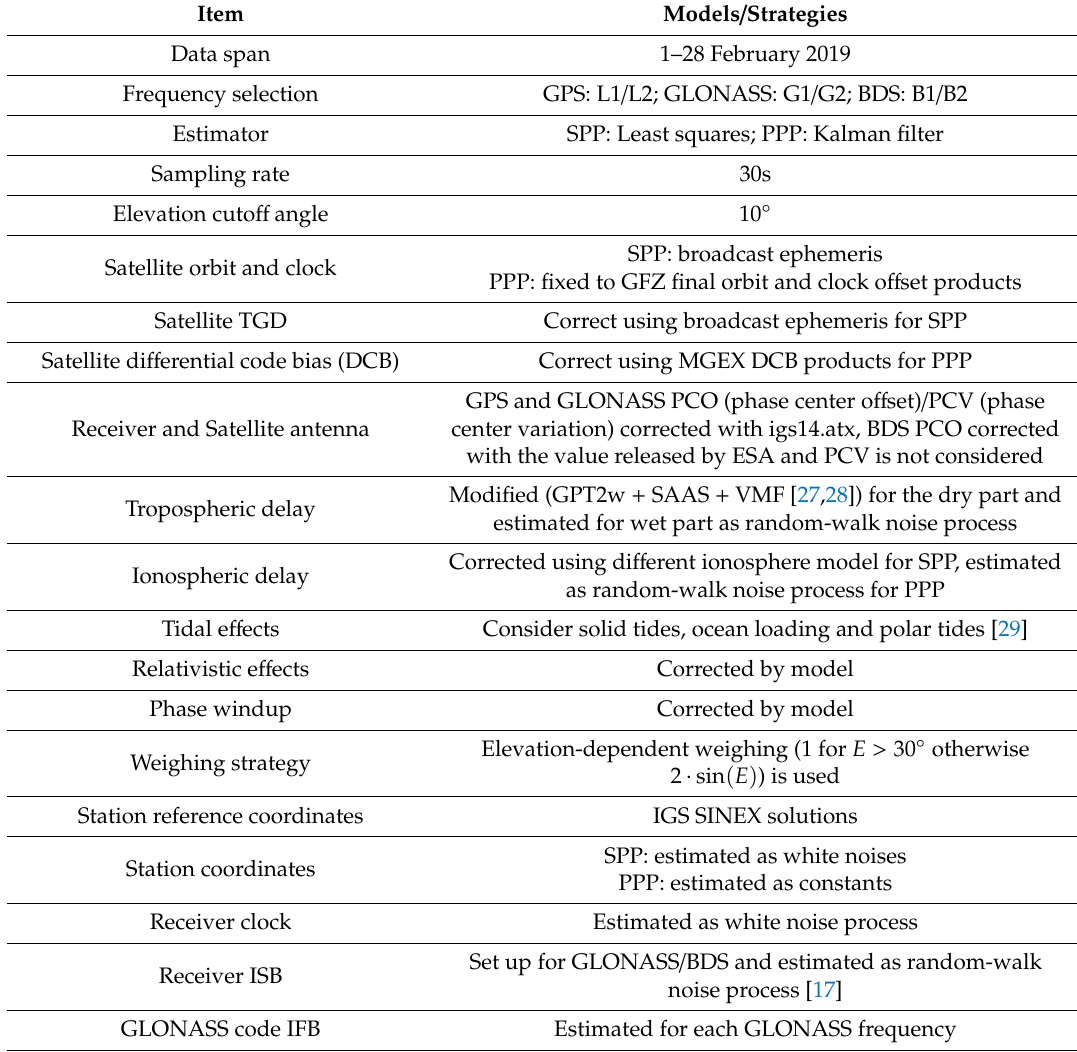
Table 1. Adopted models and strategies for multi-GNSS single-frequency SPP /